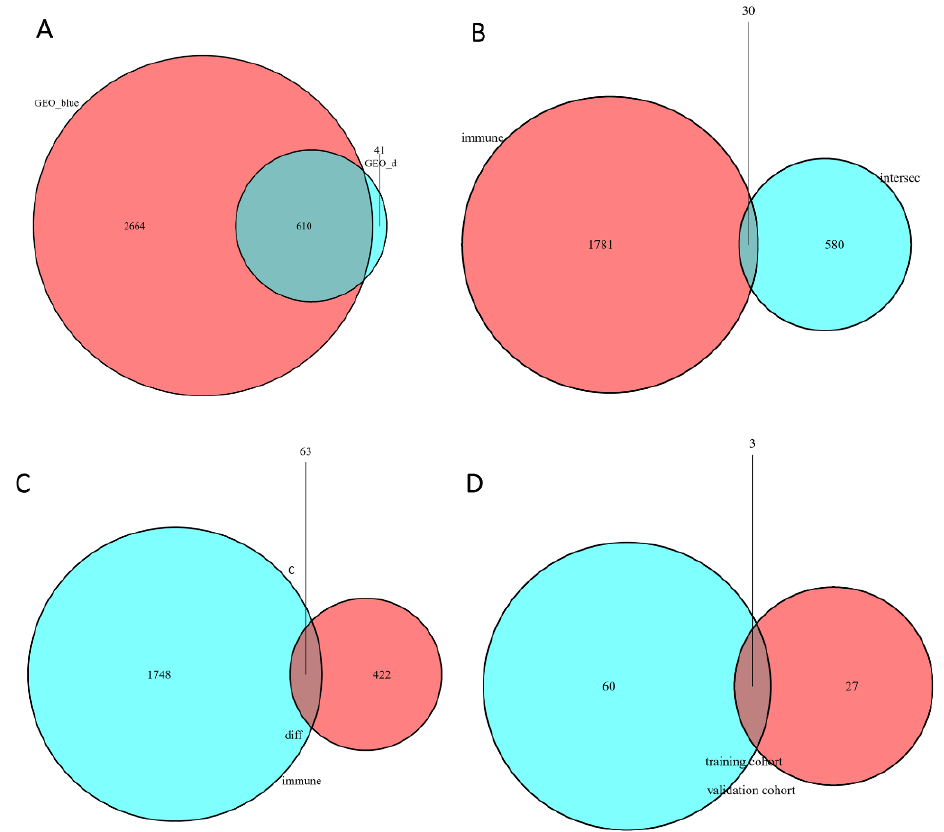
Figure 5. The exploration of BA-related immune genes. ( A ) The overlapping genes of DEGs (bule) and the blue module of WGCNA in GSE122340 (red). ( B ) The intersect genes in GSE122340 of the overlapping genes obtained from the subfigure A (blue) and the immune genes (red) downloaded from database (http://www.immport.org/). ( C ) The intersect genes of DEGs in GSE46960 (red) and the immune genes (blue) downloaded from database (http://www.immport.org/). ( D ) Identification of the target IRGs. Overlapping of immune genes in GSE122340 (red) and GSE46960 (blue)